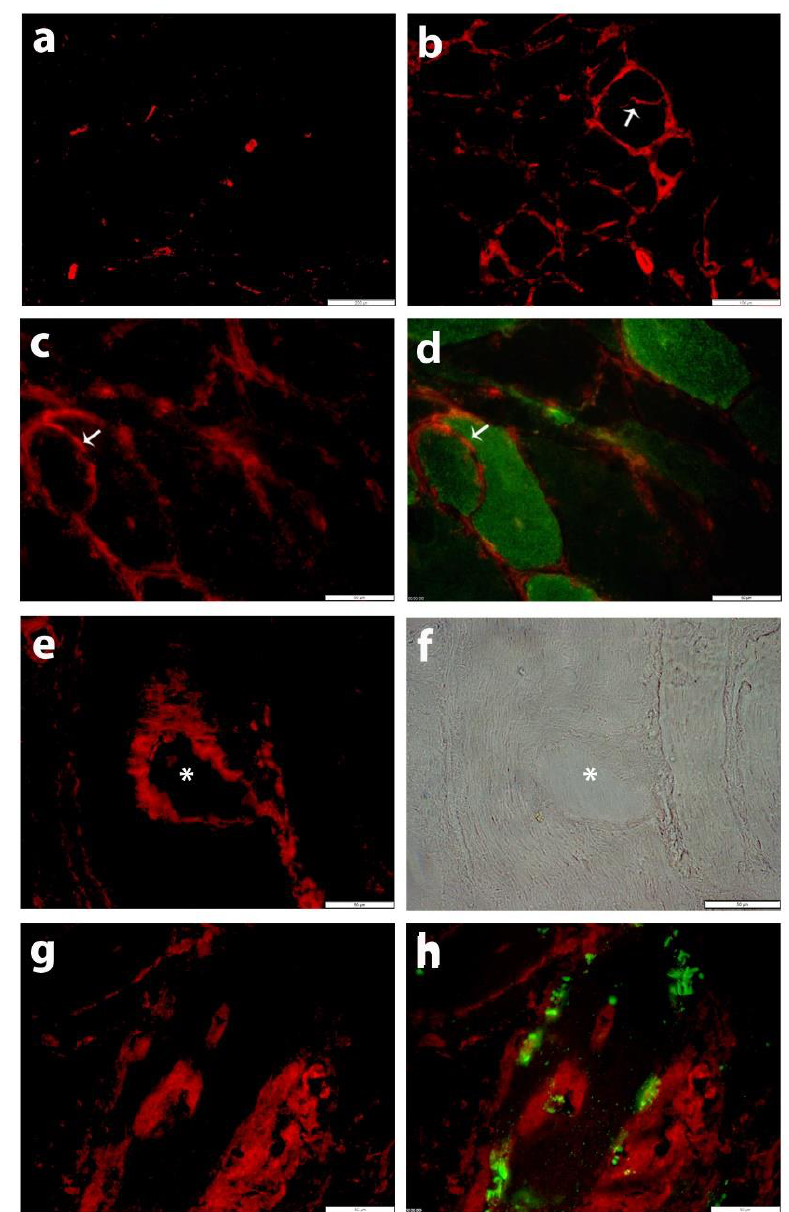
Figure 1. Immunofluorescent staining for SLC5A3 (CY3, red) with antibody Ab1. ( a ) In normal skeletal muscle tissue, staining is restricted to blood vessels and occasional partial staining of muscle fiber membranes. ( b – h ) SLC5A3 staining (CY3, red) is increased in the muscle tissue from patient IBM7: ( b ) SLC5A3 staining is observed on blood vessels, endomysial inflammatory cells and the muscle fiber membrane, including the membrane of a splitting fiber (arrow), which is a pathological feature associated with muscle tissue damage and regeneration. ( c , d ) Discontinuous membranous SLC5A3 staining is present on a small fiber that is CD56+ (AlexaFluor488, green, arrow). ( e ) SLC5A3 staining is accentuated on the rims of a vacuole, as confirmed by the phase contrast image ( f , asterisk). ( g , h ) SLC5A3 staining associates with the presence of inclusions, visualized as sequestosome 1/p62- positive (AlexaFluor488, green). Scale bars 200µm ( a ), 100µm ( b ), 50µm ( c – h ). Specific subsets of muscle-infiltrating inflammatory cells expressed SLC5A3. Many T-cells, marked as CD3+, were SLC5A3 positive (Figure 2a,b). CD206 + M2 lineage macrophages were mostly